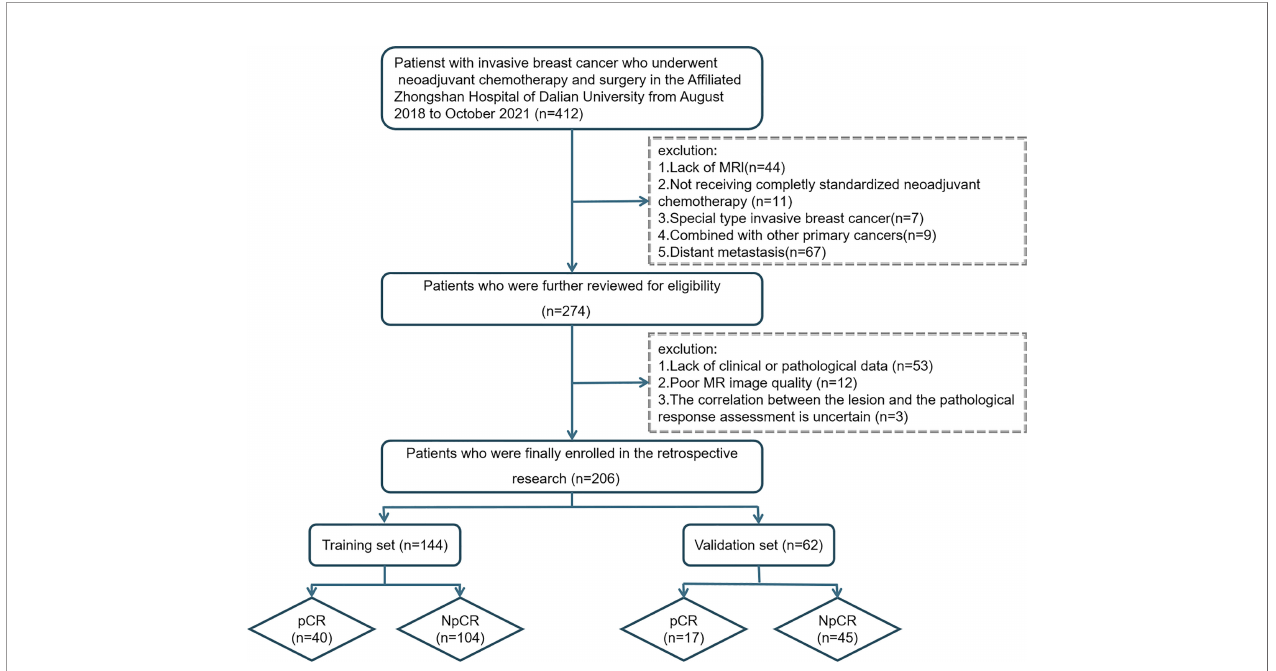
FIGURE 1 | Flowchart revealing the study population based on exclusion